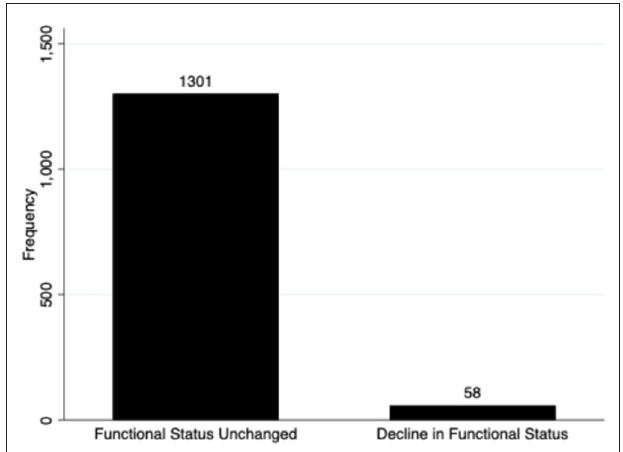
FIGURE 2 | Frequency of the primary outcome, a decline in functional status.